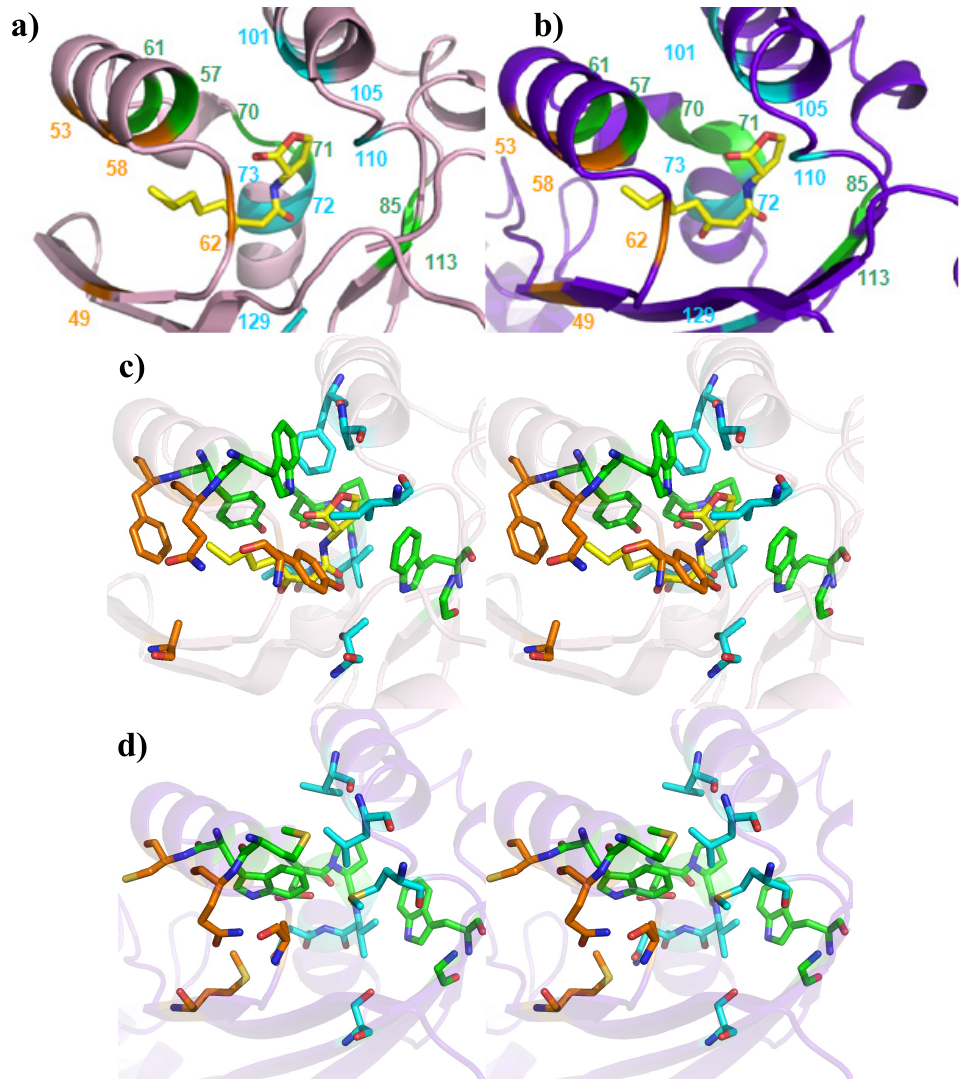
Figure 5. Comparison of the ligand-binding sites of prototypes of QS LuxRs and PAB LuxR solos subfamily (Top view). Mapping of the three Clusters of residues in ( a ) and ( c ) on the X-ray crystal structure of TraR, in complex with OC8-HSL (PDB_ID 1H0M [24]), showing the C trace and stereo view of the side chains, respectively; in ( b ) and ( d ) on the α homology model of OryR, the C trace and stereo view of the side chains orientations can α be seen. Residues have been labeled according to the TraR numbering scheme. The carbon, nitrogen and oxygen atoms of OC8-HSL, are colored in yellow, blue and red respectively. Figures produced by Pymol